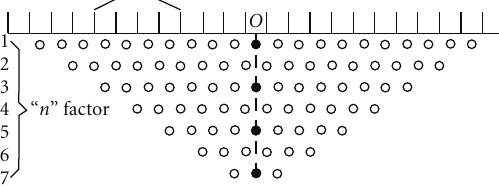
Figure 6: The illustration of extracting apparent resistivity set for Wenner- α array. In the studies on apparent resistivity anisotropy at point O , we need the apparent resistivity data arranged along the vertical dash line. According to the characteristics of Wenner- α array, the apparent resistivity measurements could be extracted every one “ n ” factor. That is, the apparent resistivity measurements just corresponding to odd “ n ” factors and on the vertical dash line will be extracted out. Black solid circles represent the extracted data.